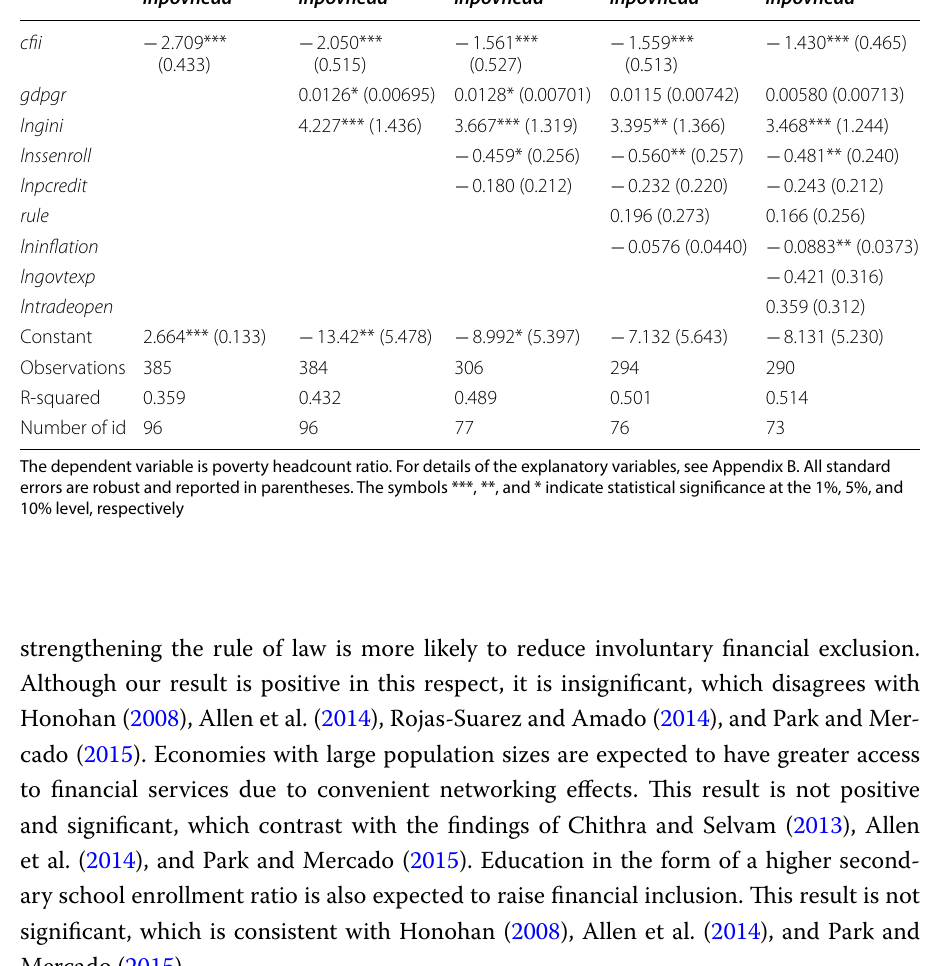
Table 3 Financial inclusion and poverty (fixed effect estimation)